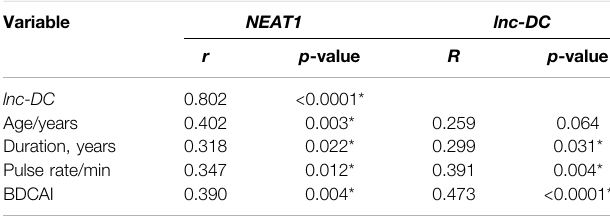
TABLE 4| Correlationanalysisbetween NEAT1 and lnc-DC andnumericaldataof patients. Variable NEAT1